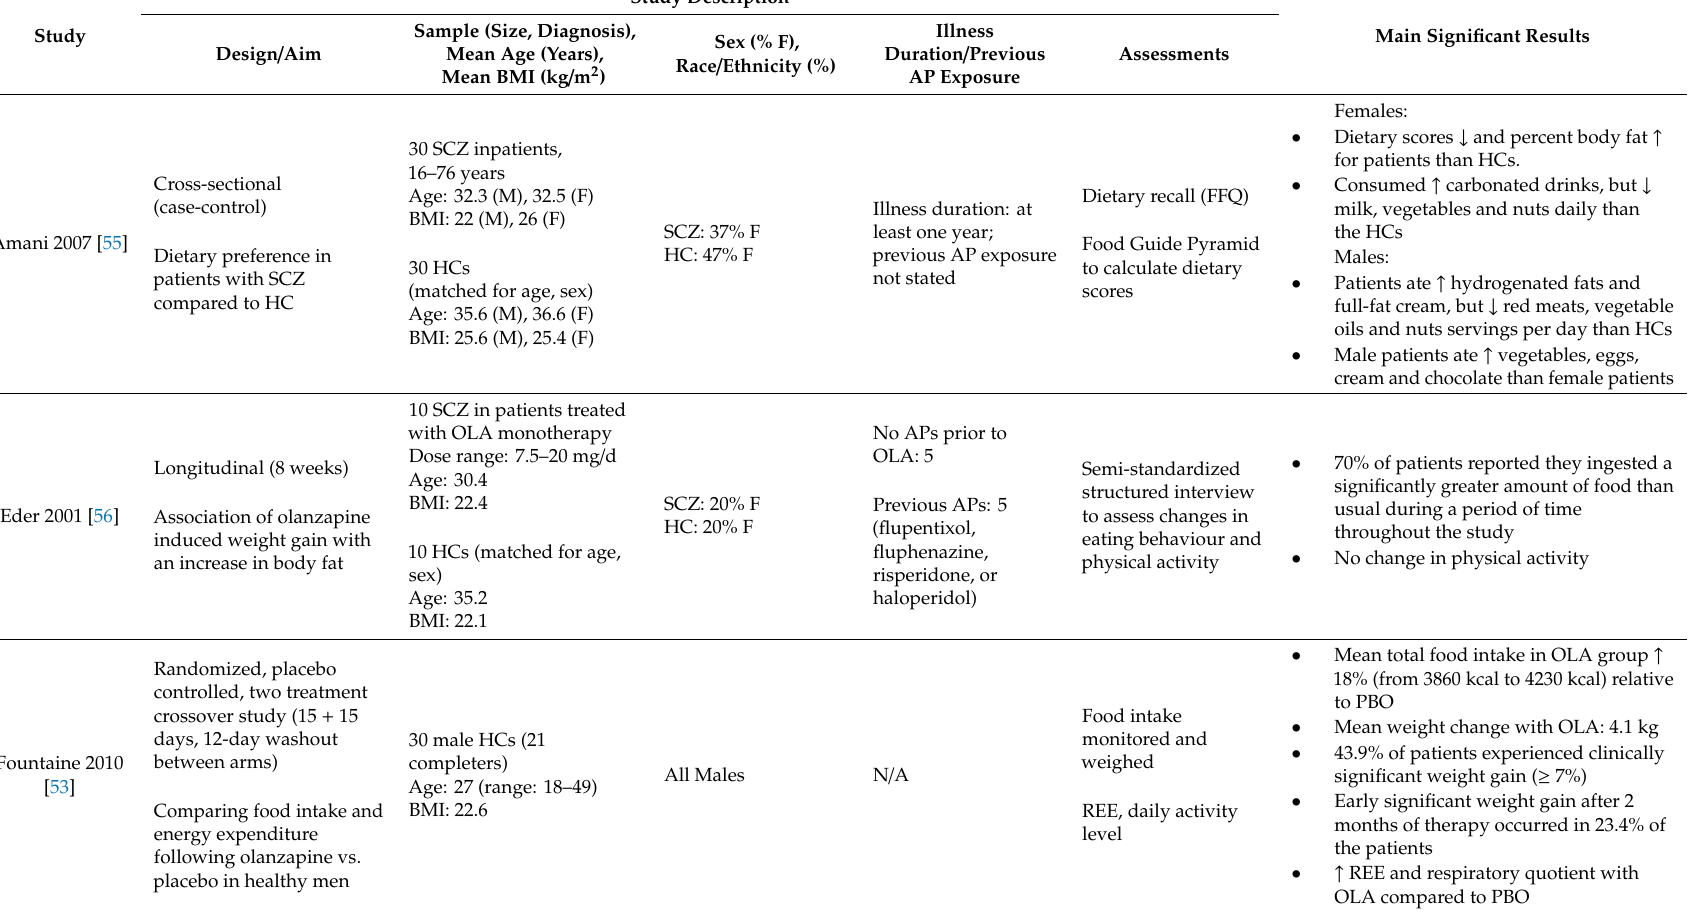
Table 4. Characteristics of studies reporting on dietary